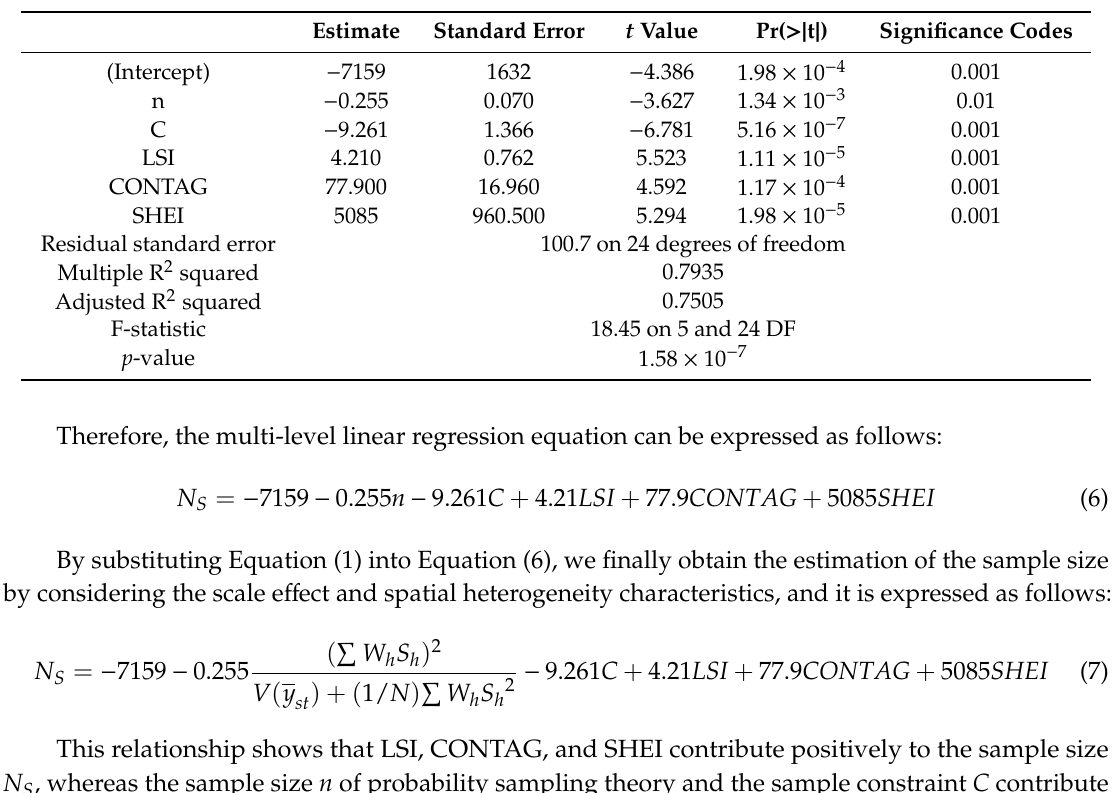
Table 5. Modified multi-level regression coe ffi cient of sample size N S .